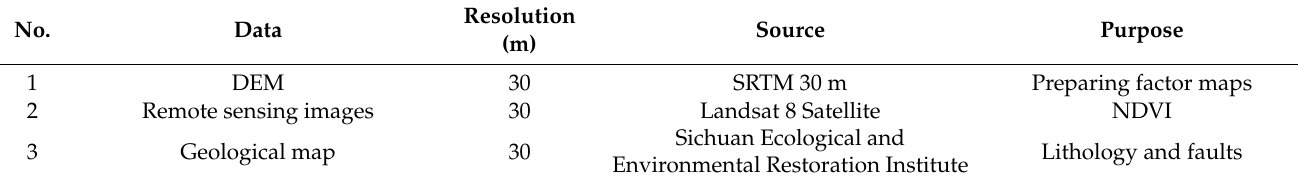
Table 1. Data and data